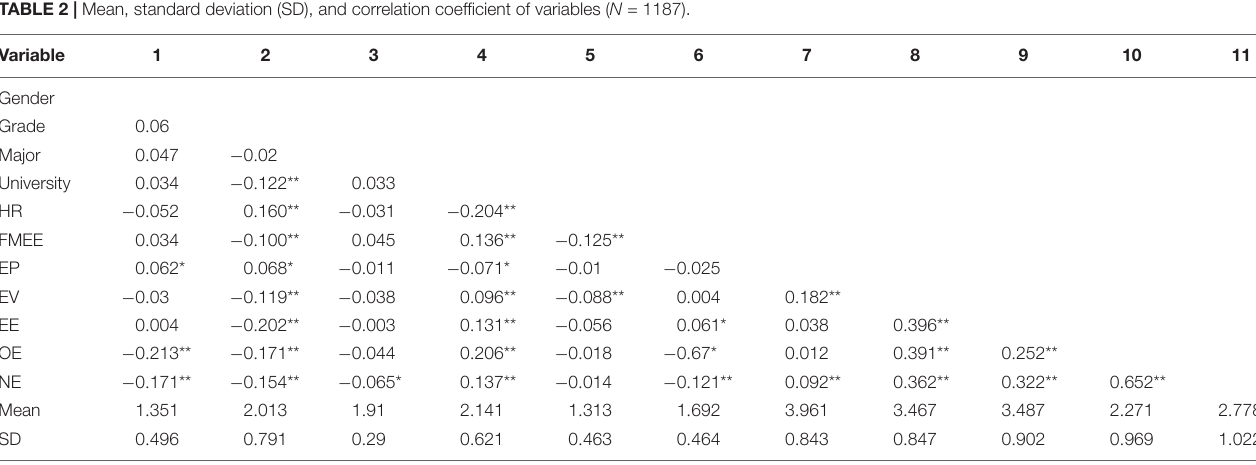
TABLE 2 | Mean, standard deviation (SD), and correlation coefficient of variables ( N = 1187).